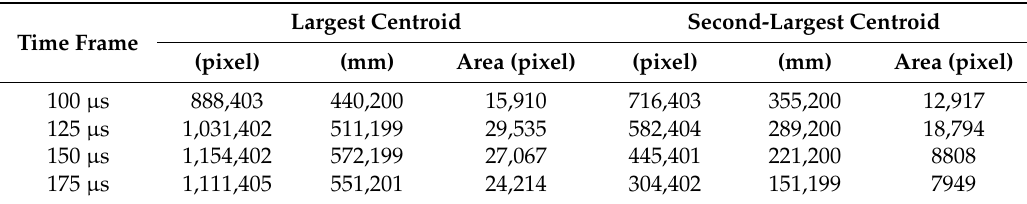
Table 2. X, Y—Area and coordinates of the largest and second largest centroid.